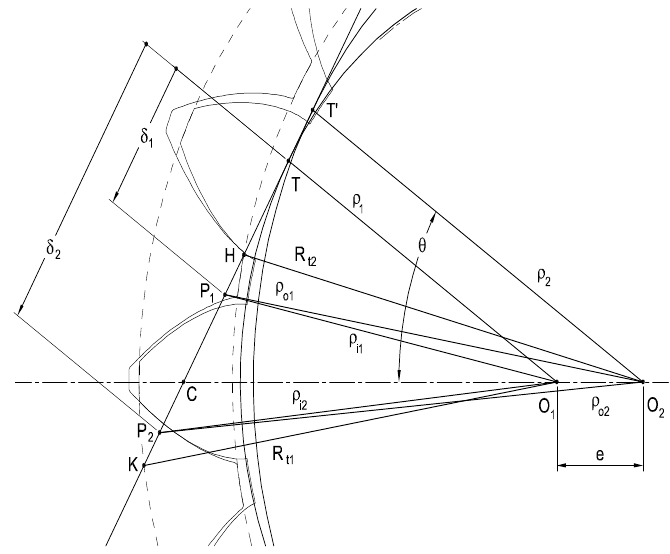
Figure 3. Line of contact, vector rays and auxiliary variables δ .